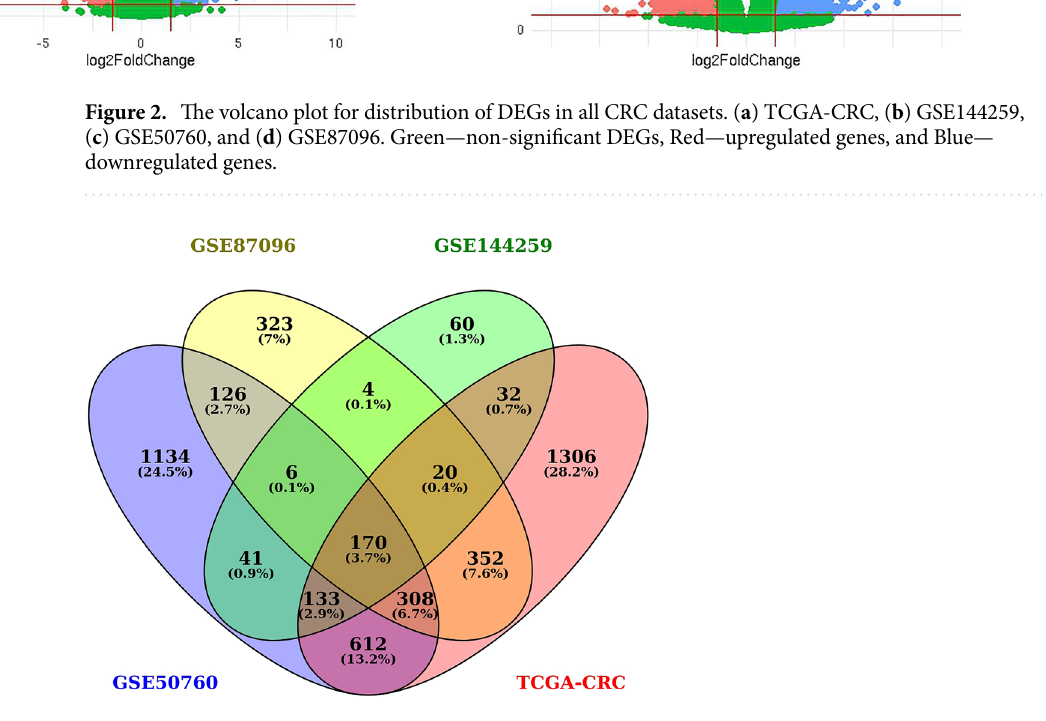
Figure 3. Venn diagram for a common significant number of genes between all four CRC